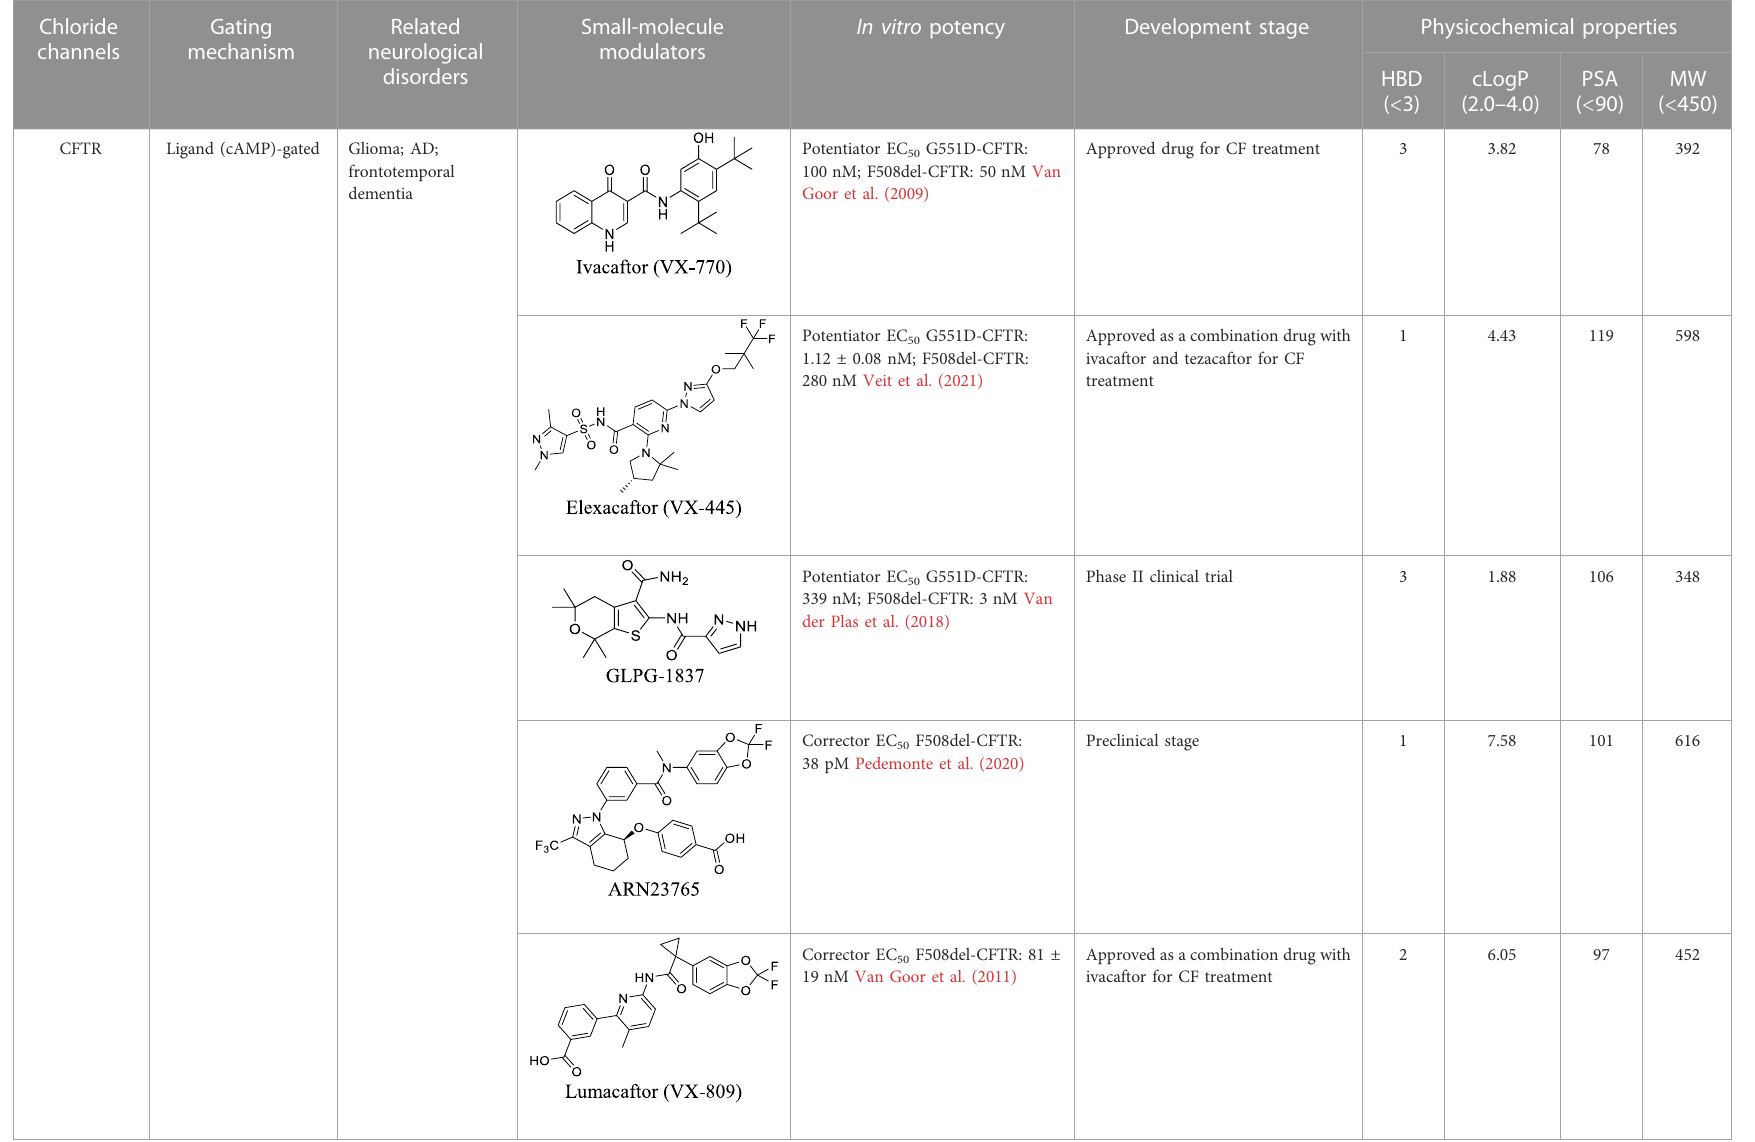
TABLE 1 ( Continued ) Summary of chloride channels involved in neurological disorders and their small-molecule modulators with physiochemical